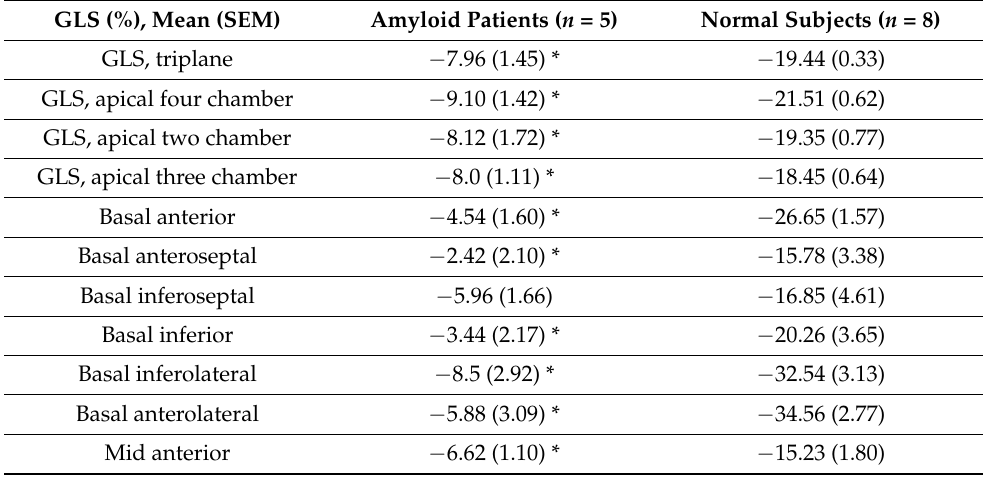
Table 1. Left ventricle longitudinal strain characteristics of amyloid patients compared to normal subjects using speckle tracking